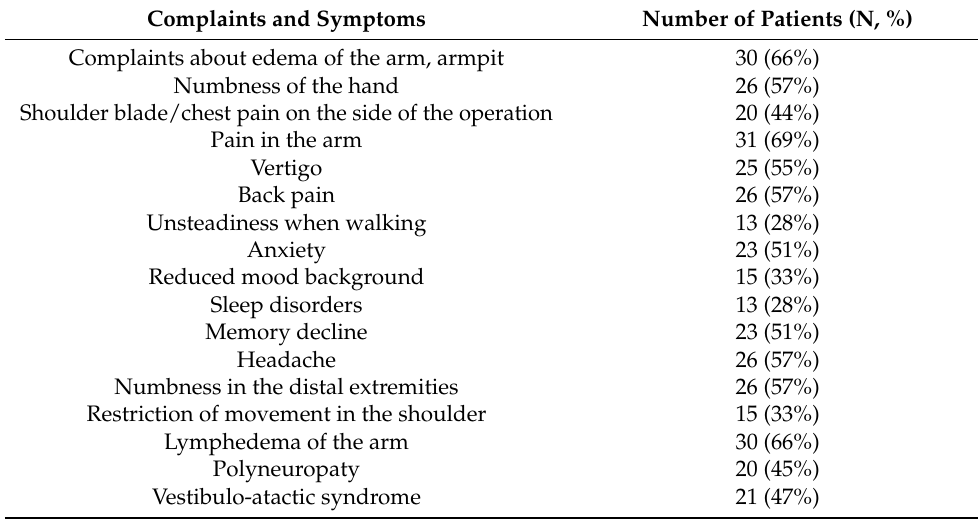
Table 2. Symptoms and complaints in breast cancer survivors.